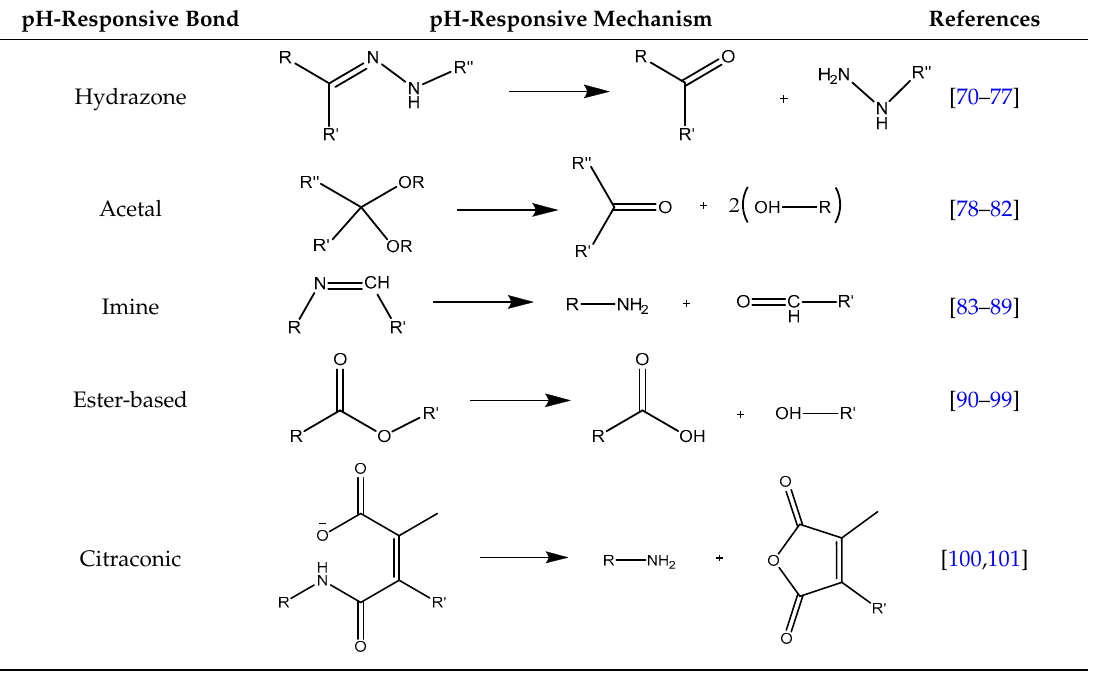
Table 1. Acid-labile bonds that have been employed for the design of different pH-responsive mesoporous nanoparticles.